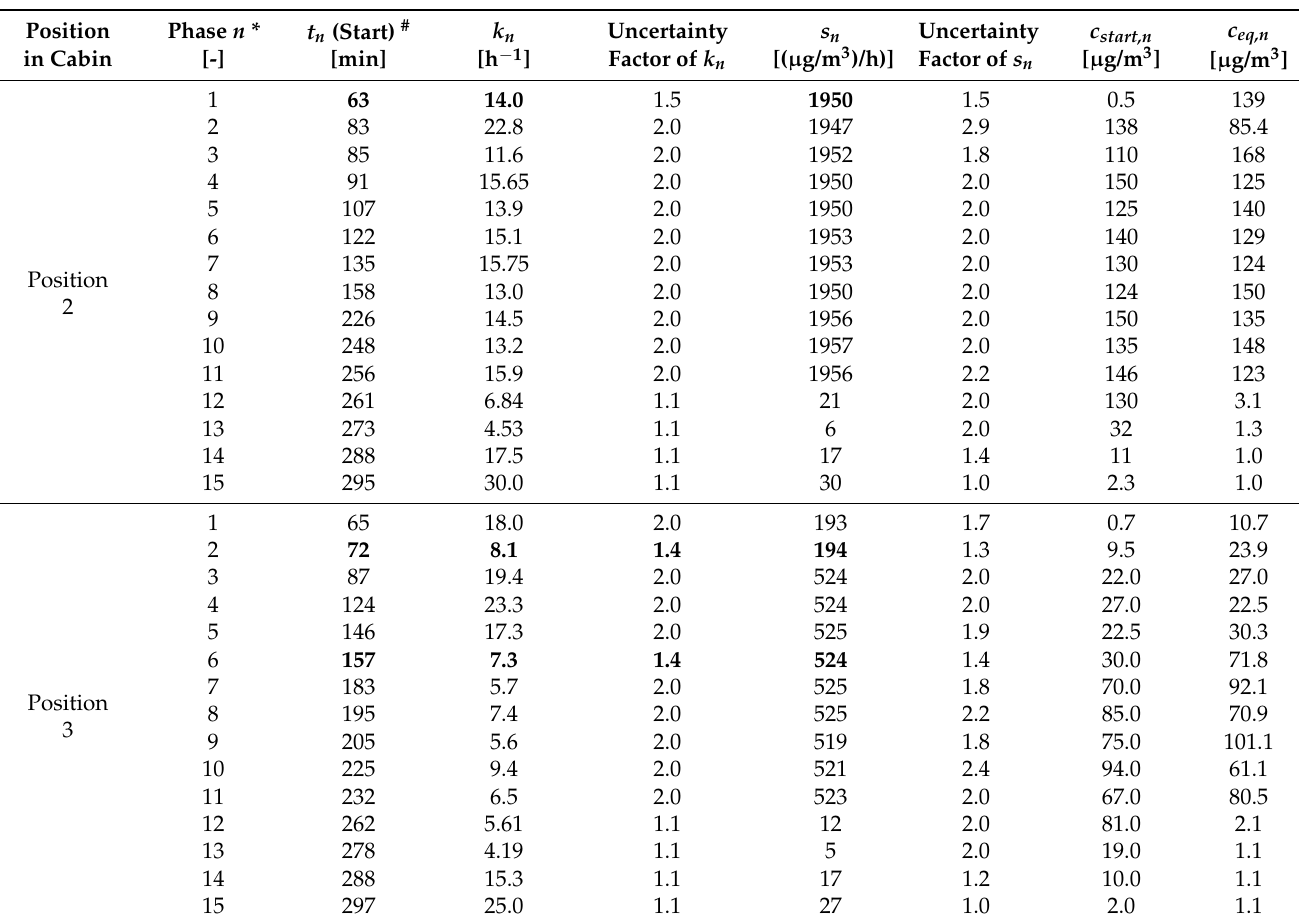
Table 6. Fitting parameters k n and s n for the fitting curves for position 2 and position 3 and derived concentrations c start,n at the beginning of phase n and equilibrium concentrations c eq,n . The bold type values were used for the initial determination of k n . In the other phases, the assumption of a constant source term was